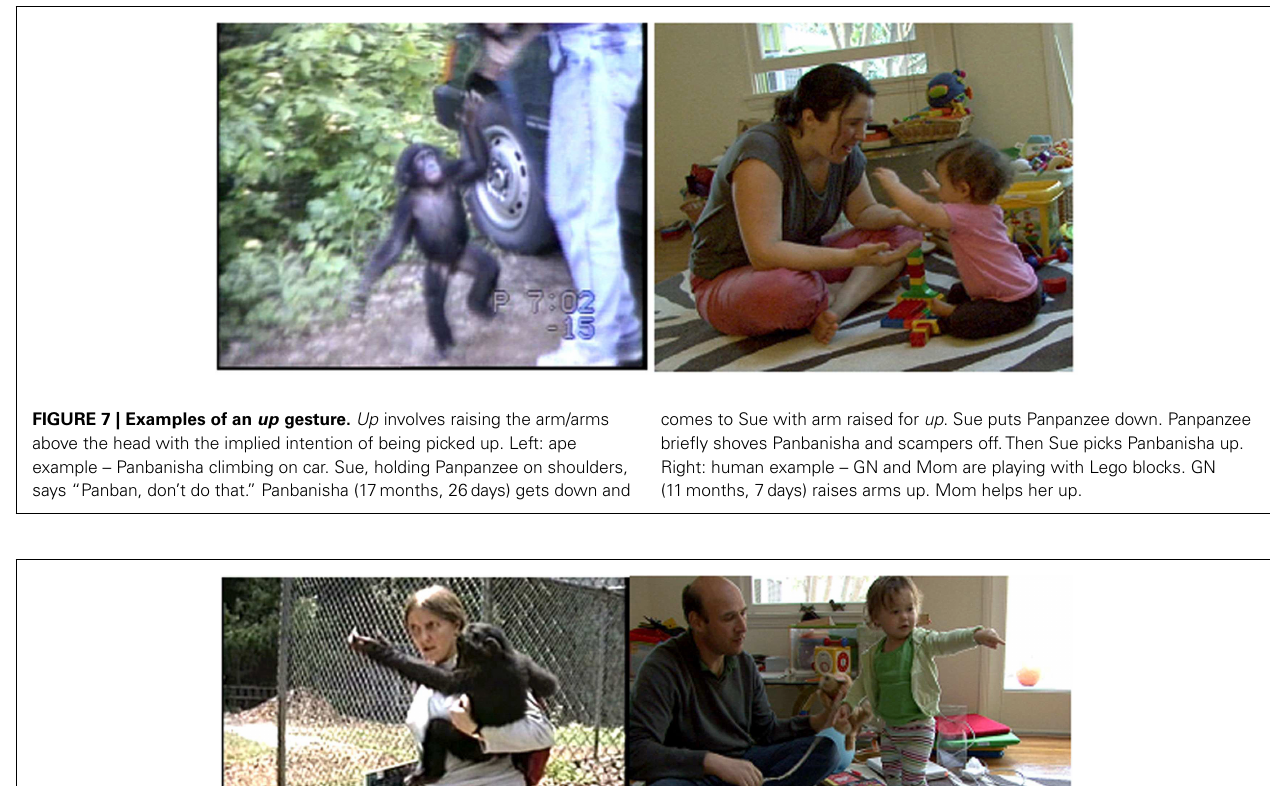
(21months, 2days). Panpanzee gestures to go. Rose walks in the direction gestured. Right: human example – Dad asks GN (15months,